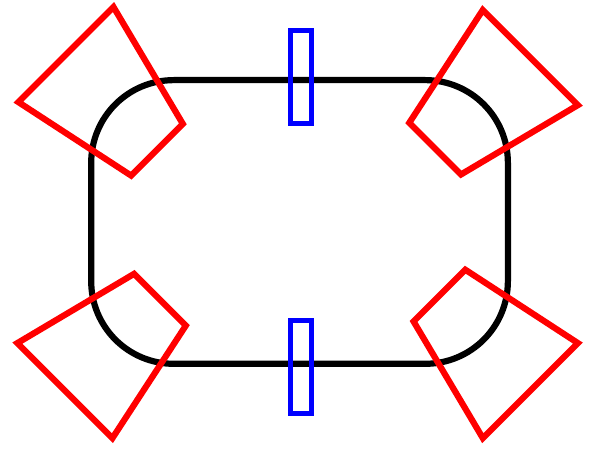
FIG. 11. TTX layout: Four dipoles in red and two focusing quads in blue.